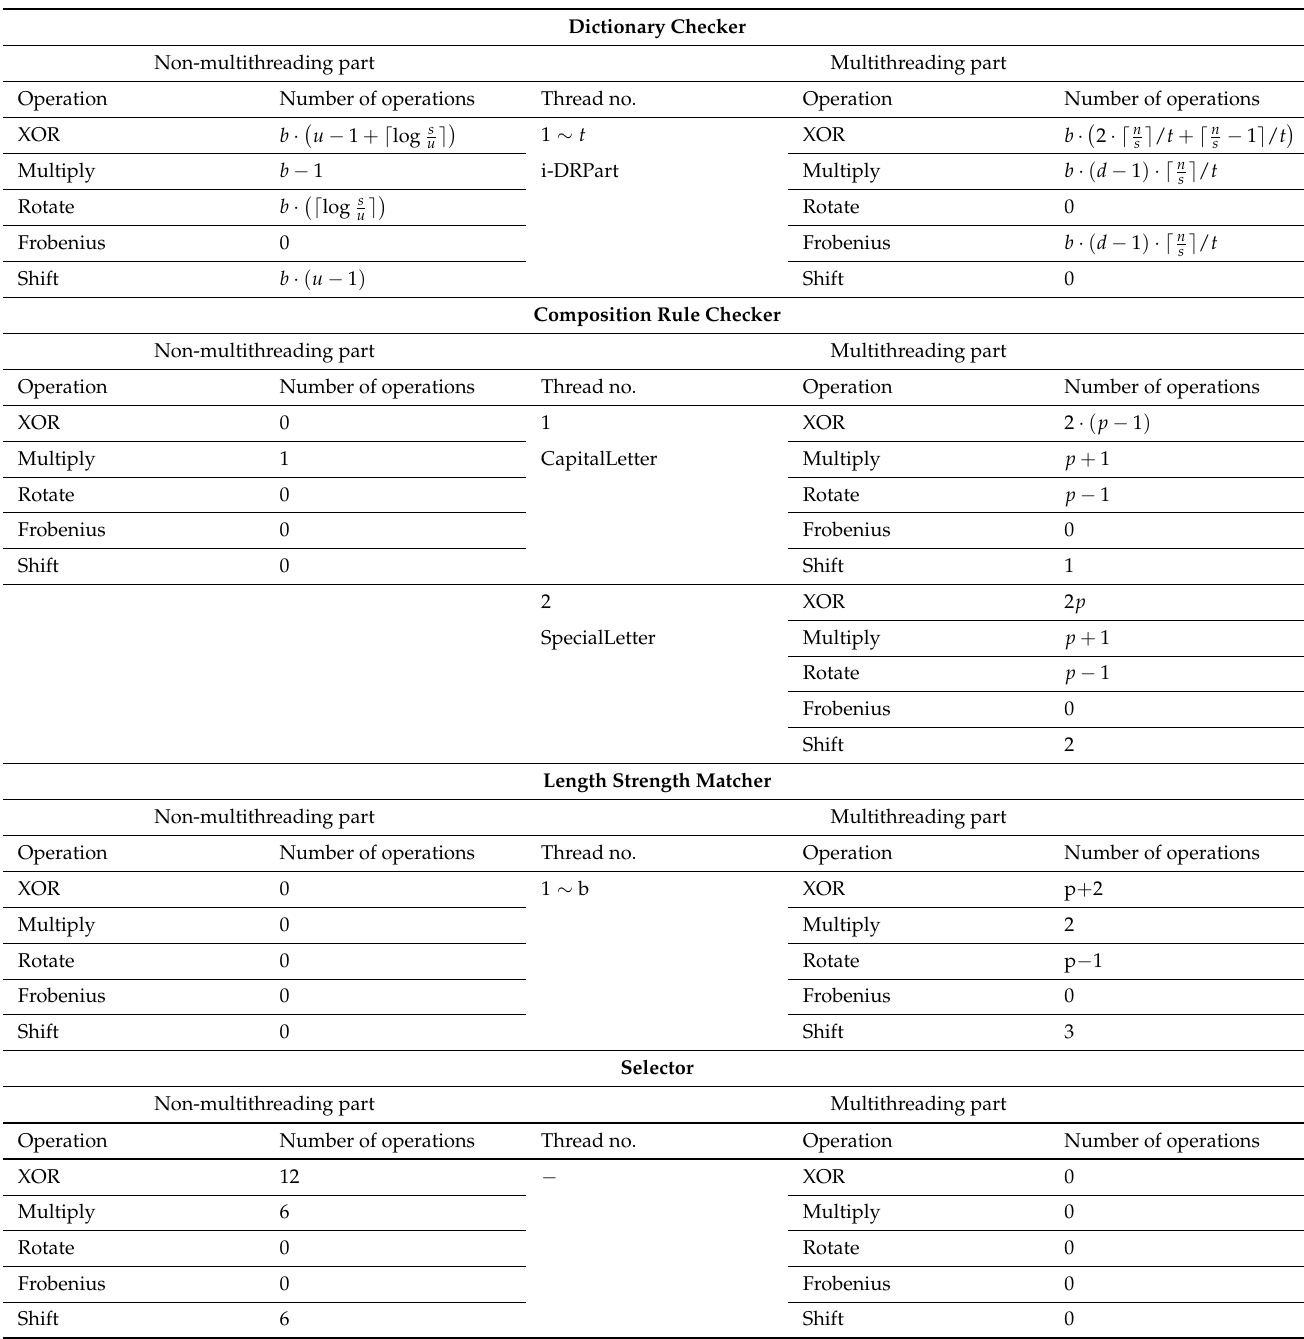
Table 4. Analysis on the number of unit